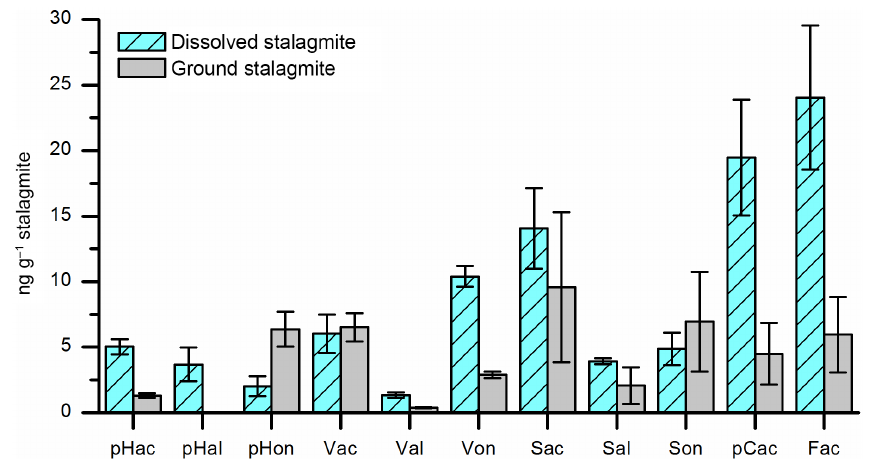
Figure 5. Results of dissolved stalagmite samples (light blue bars with diagonal stripes) compared to ground stalagmite samples (grey bars). Dissolving of the samples led to higher amounts of